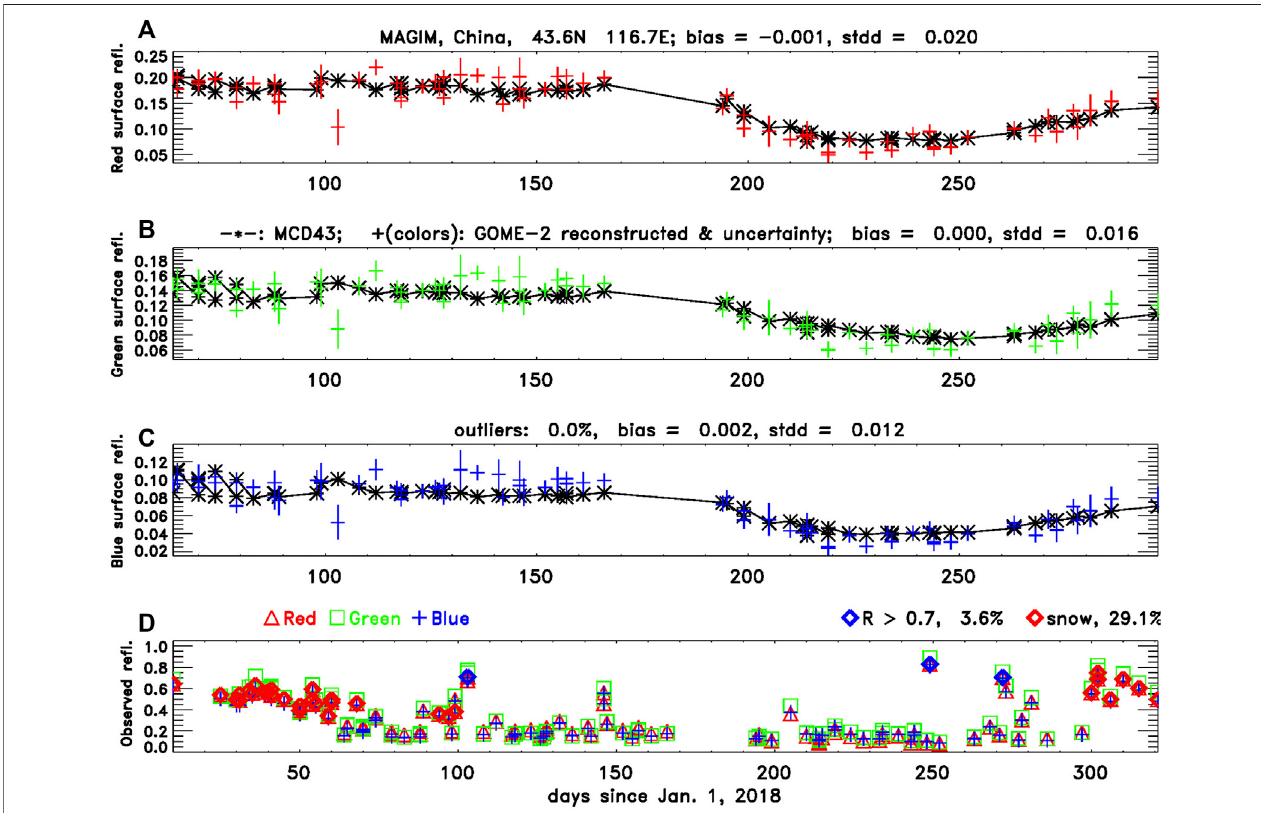
FIGURE 9 | Time series near the MAGIM eddy covariance site in China of target (MCD43, black line with stars) and reconstructed surface re fl ectances (GOME-2: colored + with extended lines in the y direction to indicate the one standard deviation uncertainty) for (A) Red; (B) Green; and (C) Blue bands, and (D) Observed re fl ectances from GOME-2 pixels. Bias and standard deviation of the reconstructed re fl ectances with respect to the target are provided for each band (color). The number of outliers found by the four standard deviation outlier check is indicated in (C) (in this case zero). Points fi ltered by the quality assurance (QA) checks are givenin (D) includingsnow(red diamonds), extremelyhigh cloudiness(bluediamonds),or poorlyreconstructed spectrafromtheleading14principal components (none in this case).